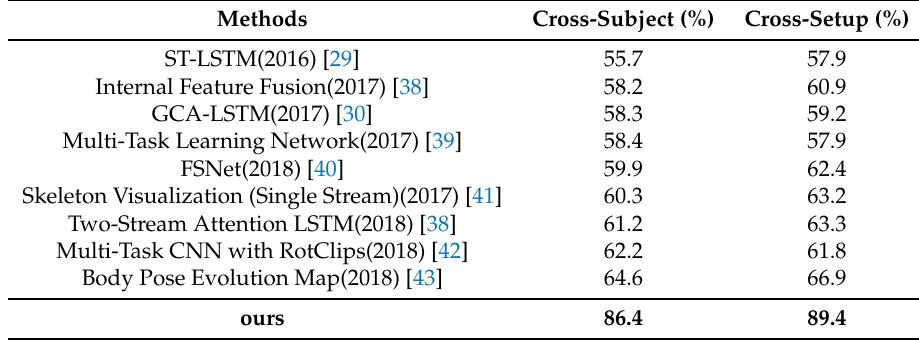
Table 6. The results of different methods, which are designed for 3D human activity analysis, using the cross-subject and cross-setup evaluation criteria on the NTU RGB+D 120